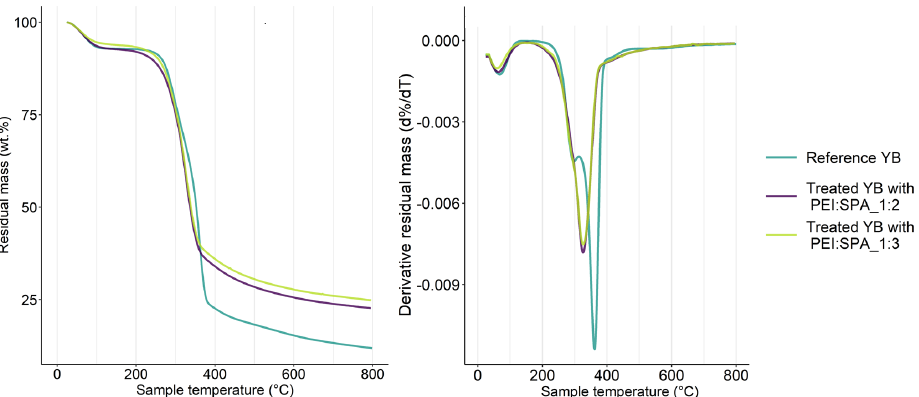
Figure 11. TG ( left ) and DTG ( right ) curves for reference YB and treated YB with different